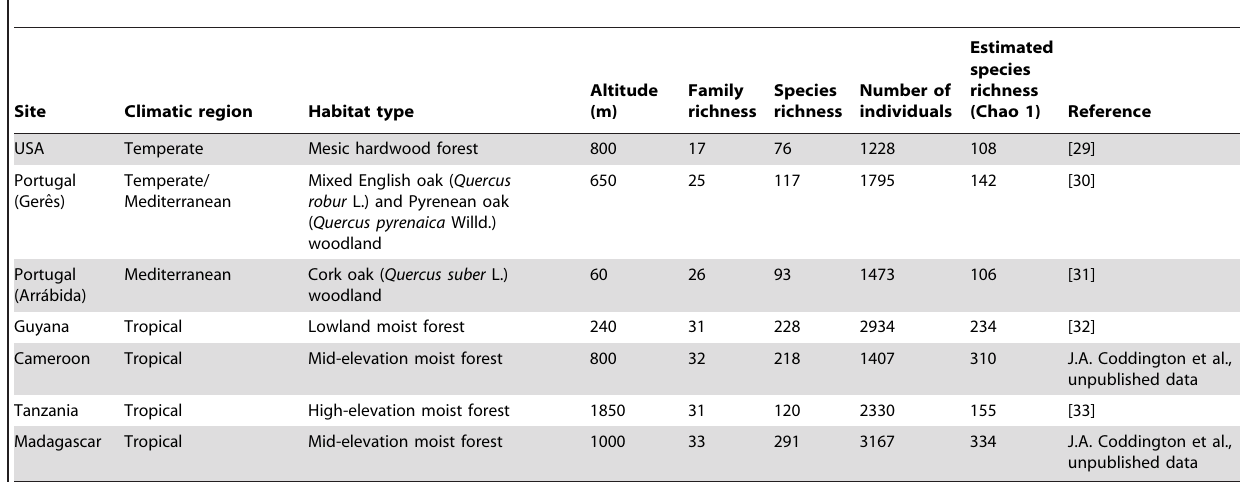
Table 1. Overview of studied sites and respective biogeographical, ecological and spider assemblage